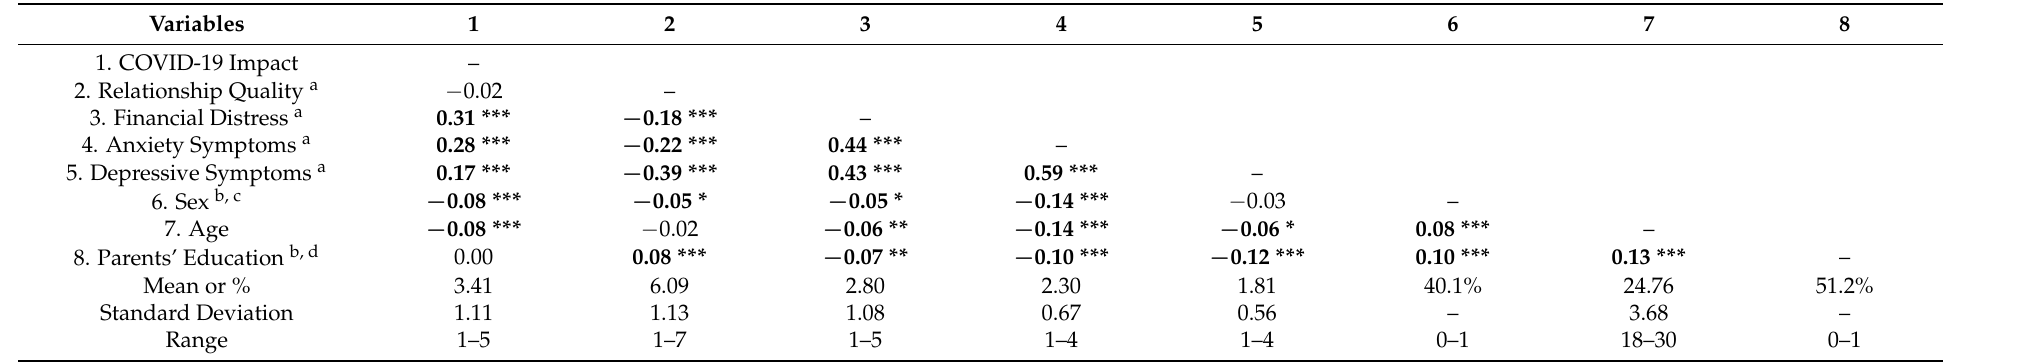
Table 1. Descriptive statistics and bivariate correlations (N =